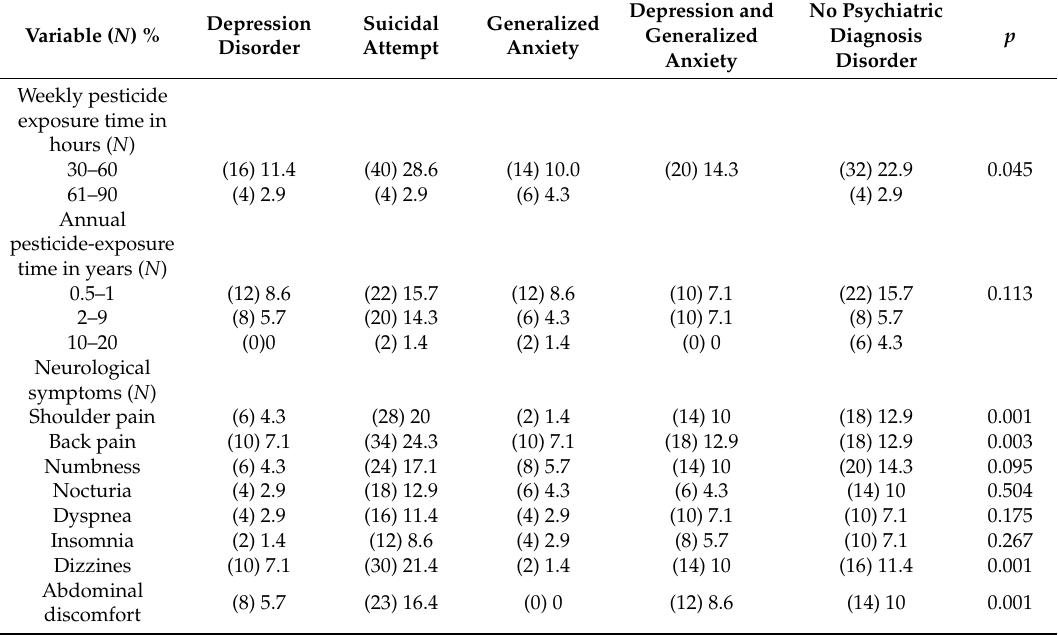
Table 4. Risk of toxicity and neurological symptoms of the exposed participants diagnosed with psychiatric disorders. p -values were obtained by the Chi-Square test. p < 0.05 was considered statistically significant. The percentage was calculated concerning the exposed participants. Percentages were determined concerning the total of the exposed